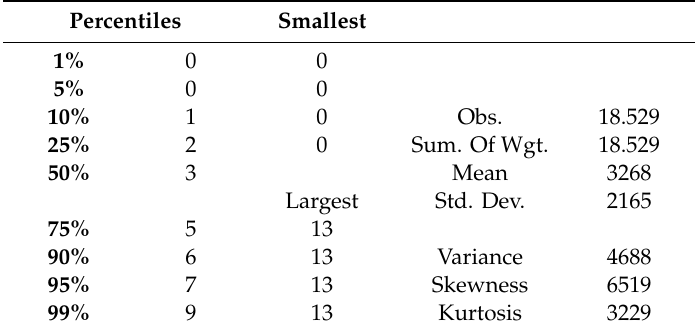
Table 1. Summary statistics on action to mitigate climate